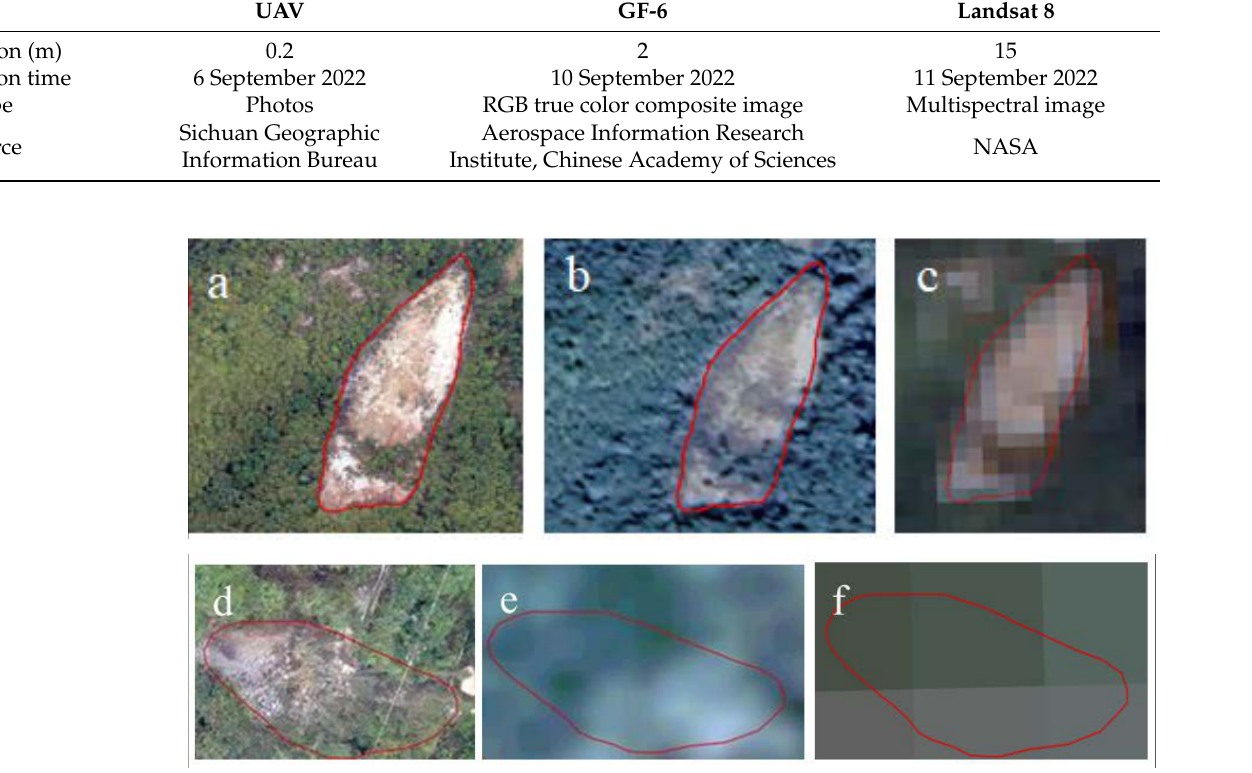
Figure 2. Schematic diagram of different scales landslides in each image (Landslide 1, covering an area of 21,680 m 2 , located at 102°9 ′ 6 ″ E, 29°31 ′ 53 ″ N; ( a ) clear landslide in UAV image ( b ); clear landslide in GF-6 image ( c ); clear landslide in Landsat 8 image; Landslide 2, with an area of 419 m 2 , location: 102°8 ′ 27 ″ E, 29°31 ′ 54 ″ N ( d ); the landslide is relatively identifiable in the UAV image ( e ); the landslide is fairly vague in the GF-6 image ( f ); the landslide cannot be displayed in the Landsat 8 image).